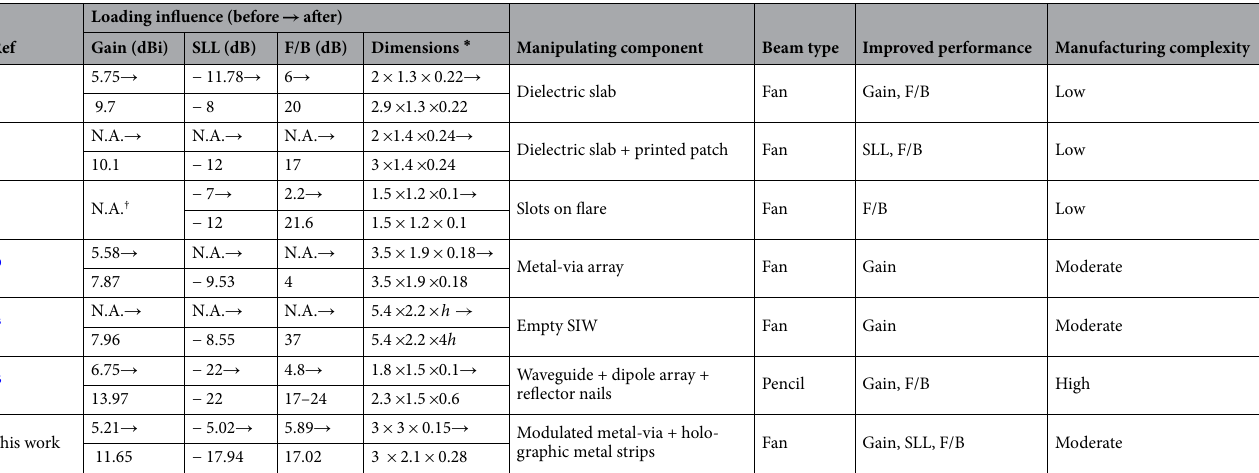
Table 3. Comparison Study of the proposed structure with the state-of-the-art. *The reported values are the maximum edge-to-edge sizes of structure in the format of “ length / (cid:31) o × width / (cid:31) o × height / (cid:31) o ” with (cid:31) o is the free space wavelength regarding the frequency at which the structure shows its optimum performance. † The reported value is for the corresponding 1 × 4 array which is 10.4